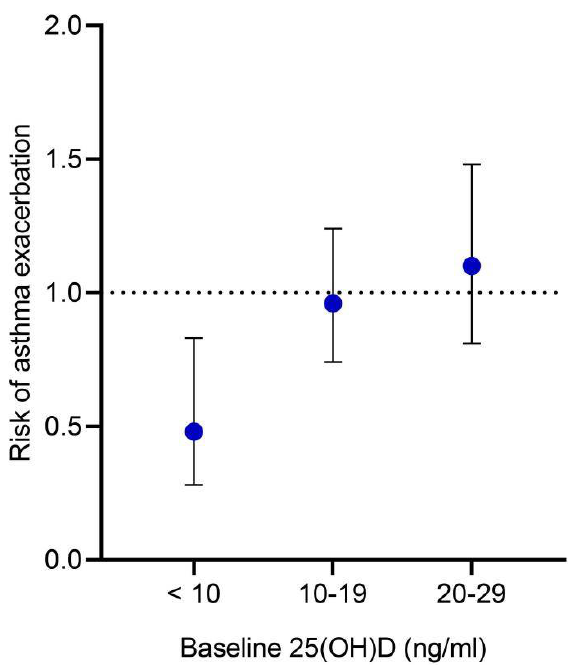
Figure 3. Subgroup analysis of the number of children with one or more asthma exacerbations by baseline serum 25(OH)D concentration. Risk ratio and 95% confidence intervals are presented. Note: we were unable to assess the subgroup of children with baseline 25(OH)D levels ≥ 30 ng/mL